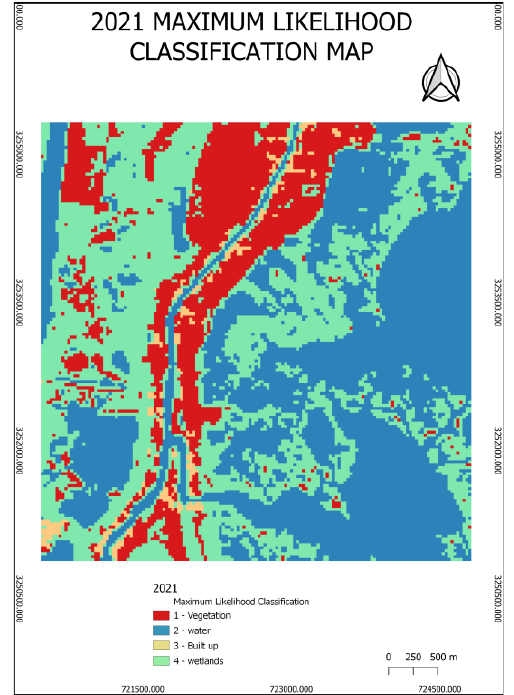
Fig.4 A 2021 map showing current land use classes for